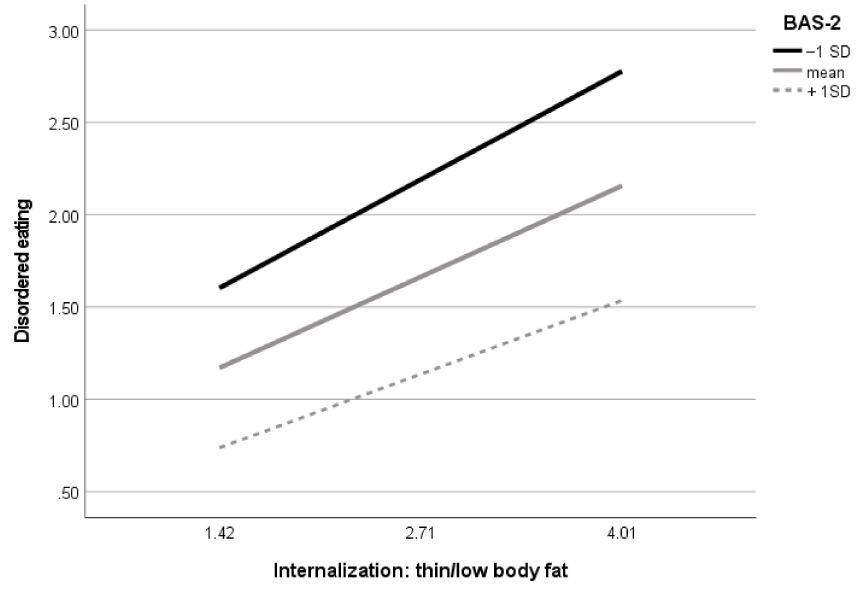
Figure 4. Visualization of body appreciation moderating effect in the association between internaliza- tion of thin body with low fat and disordered eating in girls ( n = 842). BAS-2 = Body Appreciation Scale-2, SD = standard